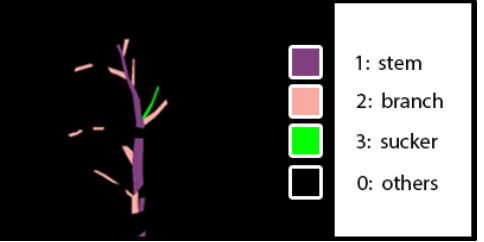
Figure 3. A visualized example of a ground-truth label image.